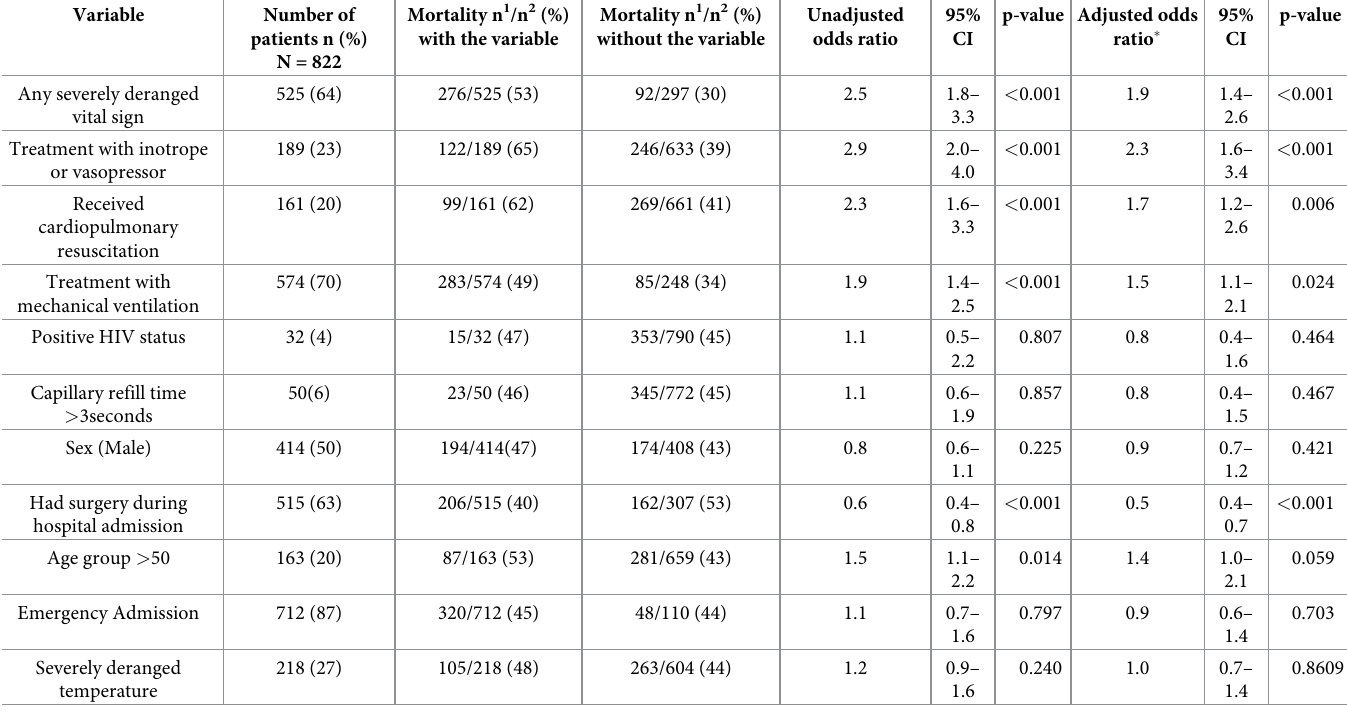
for the 722 patients of age 16 years and above are shown in Table 3. Four hundred and eighty- Table 2. Factors associated with in-hospital